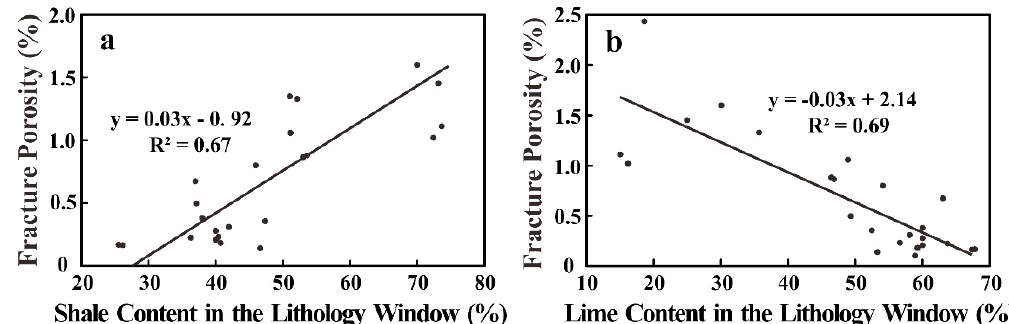
Figure 6. The relationship between each content and fracture porosity in a window of 2 m.: ( a ) The relationship between fracture porosity and shale content, ( b ) The relationship between fracture porosity and lime content.